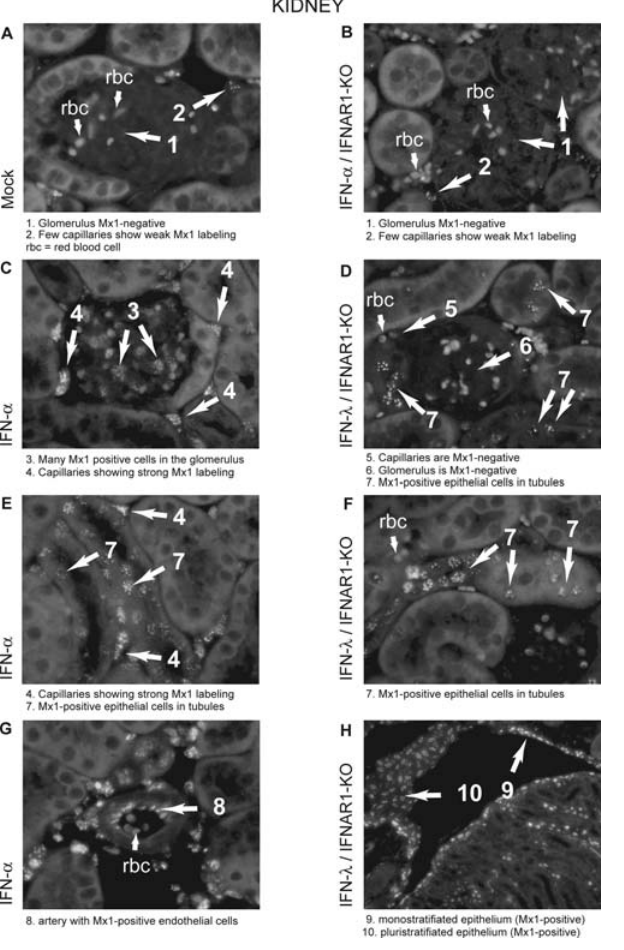
Figure 7. IFN- a and IFN- l responding cells in the kidney. Mx1 expression, detected by immunohistochemistry (white nuclear spots), 7 days after electroinjection of a plasmid coding for MuIFN- a 6T or MuIFN- l 3. Sections of the kidney from: A. control Mx1/WT mouse electro- injected with the empty vector. Note that few cells (mostly endothelial cells) were weakly Mx1-positive. B. control Mx1/IFNAR1-KO mouse electroinjected with a plasmid coding for IFN- a 6T. C–E–G: Mx1/WT mouse electroinjected with a plasmid coding for IFN- a 6T. D–F–H: Mx1/ IFNAR1-KO mouse electroinjected with a plasmid coding for IFN- l 3.